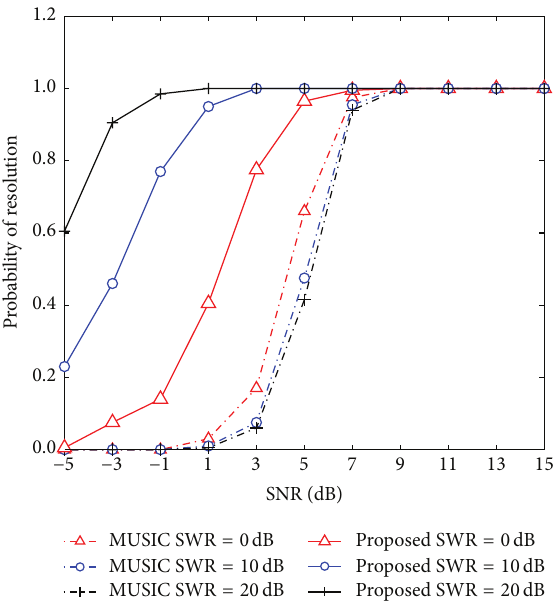
Figure4:ResolutionprobabilityagainsttheSNRoftheweaksource, where the strong source is located at (𝜃 1 , 𝛾 1 ) = (3 ∘ , 30 ∘ ) and the weak source is located at (𝜃 2 , 𝛾 2 ) = (7 ∘ ,35 ∘ ) with SNR = 5 dB.